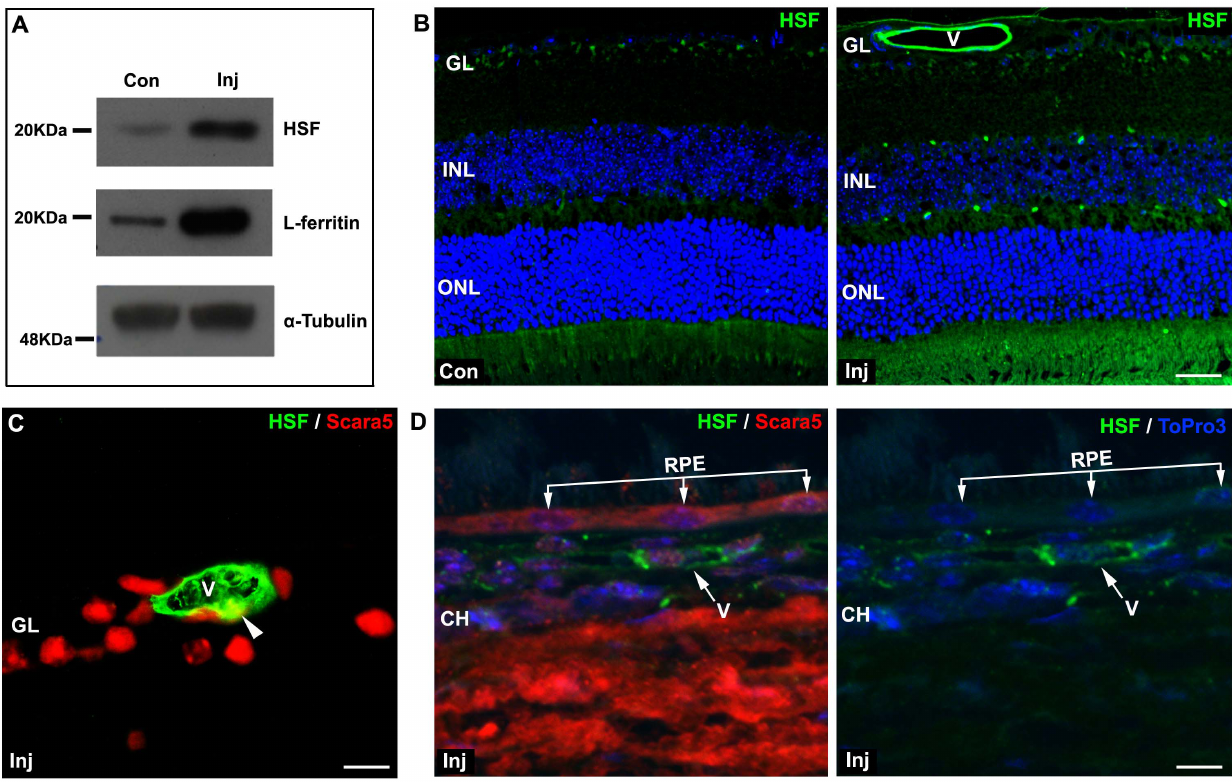
Figure 7. Intravenously injected HSF crossed the BRB. A: Six hours after the intravenous injection of HSF, western blotting analysis revealed that HSF was present in the retina. As expected, a marked increase of L-ferritin content was also confirmed. B: The immunolabeling with a specific anti-HSF antibody showed that HSF crossed the inner BRB and accumulated in mouse retina. HSF was internally lining the retinal blood vessels. C and D: The double staining with anti-HSF and with anti-Scara5 antibodies showed that L-ferritin co-localized with endothelial cytoplasmic Scara5 (arrowhead), but no content of HSF was observed in RPE cells, suggesting a differential function of the inner and outer component of BRB. Nuclei were counterstained with ToPro3. Con, non-injected control; Inj, injected; V, blood vessel; GL, ganglion cell layer; INL, inner nuclear layer; ONL, outer nuclear layer; RPE, retinal pigment epithelium; CH, choroid. Scale bars: 24 m m (B); 10 m m (C); 8 m m (D). rabbit anti-mouse transferrin (Acris, Herford, Germany), at 1:10000 dilution, and rabbit anti-mouse transferrin receptor 1 (Abcam) at 1:1000. All primary antibodies were incubated in blocking buffer of 5% non-fat milk powder in PBT (Phosphate buffered saline, 0.05% Tween-20) for 2 hours at room tempera- ture. After washing with PBT, membranes were incubated for conjugated goat anti-rabbit IgG secondary antibody (Southern